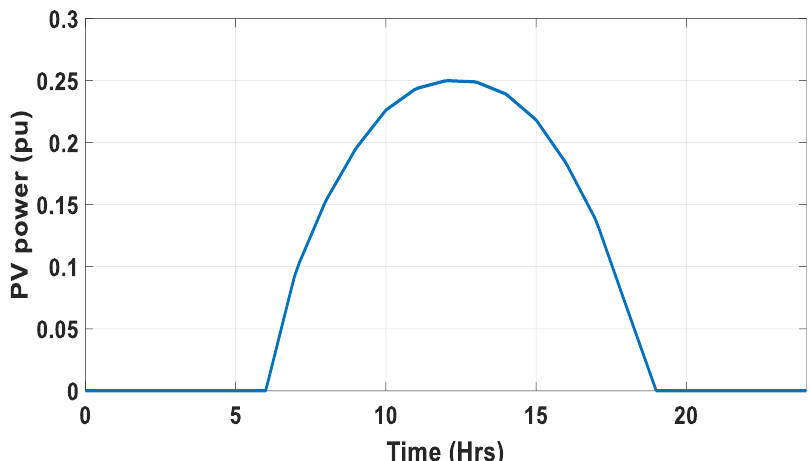
Figure 15. Wind power fluctuation.